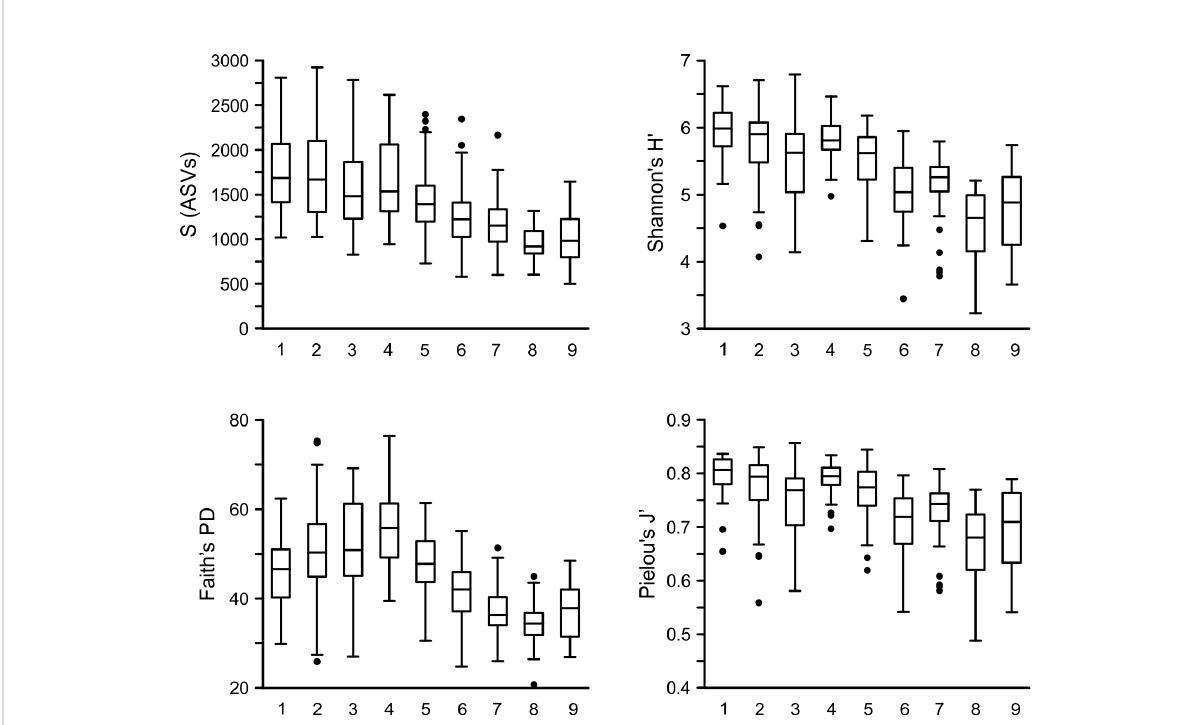
FIGURE 7 Box and whiskers graphs for the distribution of the number of taxa ( S ), Shannon ’ s H ’ , Faith PD and Pielou ’ s J ’ for all samples from each cluster at K =9. Boxes indicate median, fi rst and third quartiles. Meanwhile S and H ’ follow a decreasing pattern with depth, PD shows a maxima at cluster 4 (below the DCM), and Pielou ’ s J ’ shows three different decreasing trends, in the epipelagic, and the upper and lower